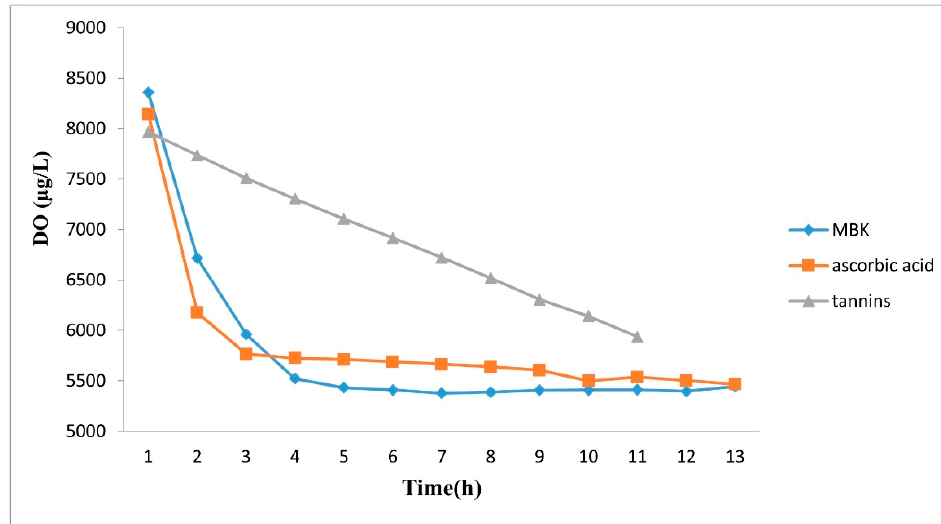
Figure 2. DO patterns in MBK, ascorbic acid and tannins water solutions over the ozone treatment time.